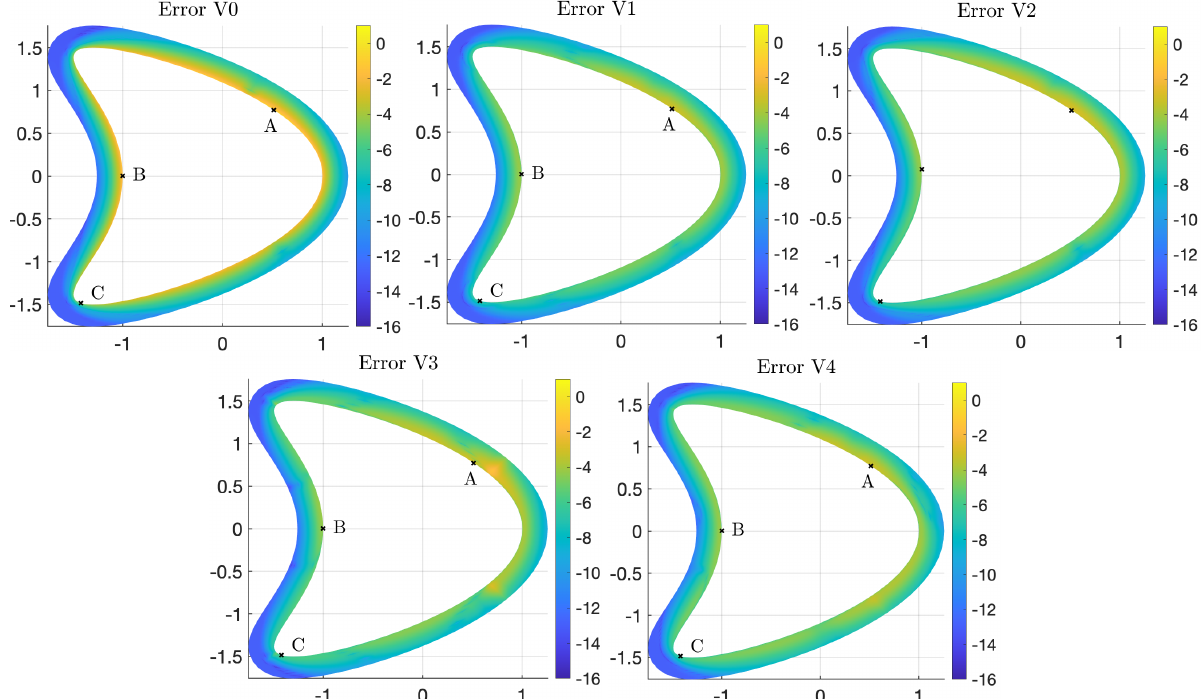
Figure 1. Laplace 2D single-layer. Plots of log of the error for the evaluation of the solution of (2) out of the kite domain 10 defined by the boundary y ( t ) = ( cos t + 0.65cos ( 2 t ) − 0.65,1.5sin t ) , t ∈ [ 0,2 π ] , for the Neumann data, g = ∂ n u exact with x 0 = ( 0.1,0.4 ) , for representations V0, V1, V2, V3, V4 computed using PTR with N = 128. Computations are made on a boddy-fitted grid with N × 200 grid